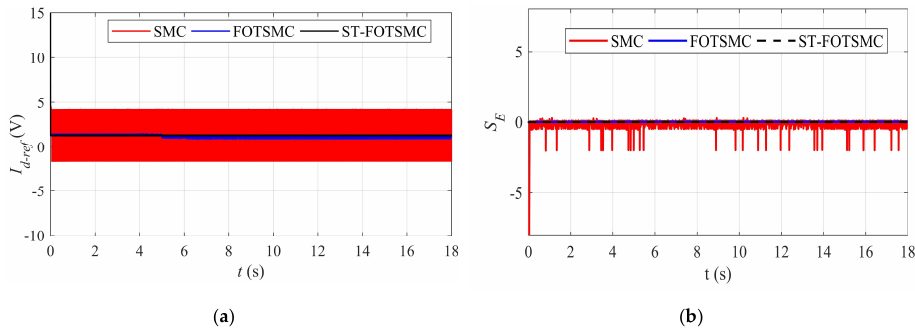
Figure 9. ( a ) DC-link voltage; ( b ) DC-link voltage error comparison under normal conditions.